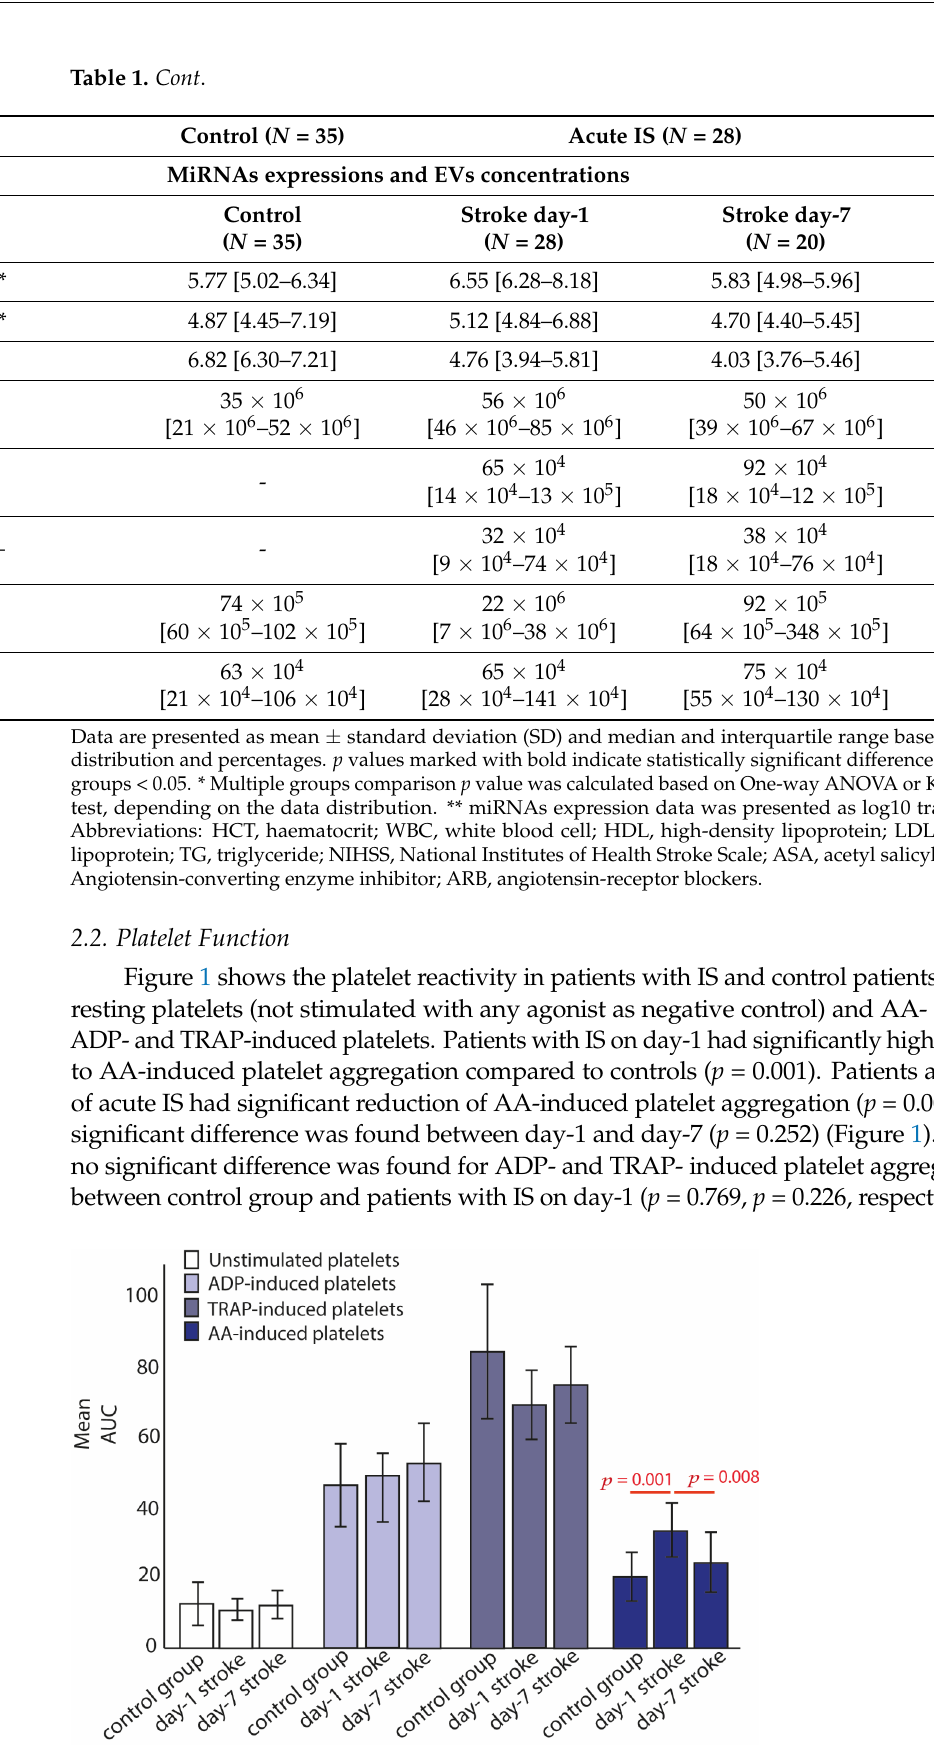
Figure 1. Platelet reactivity in blood in response to arachidonic acid (AA-test), adenosine diphosphate (ADP test), and thrombin receptor-activating peptide-6 (TRAP test). Unstimulated platelets (no agonist) were used as a negative control. p value was calculated with paired or unpaired t test,